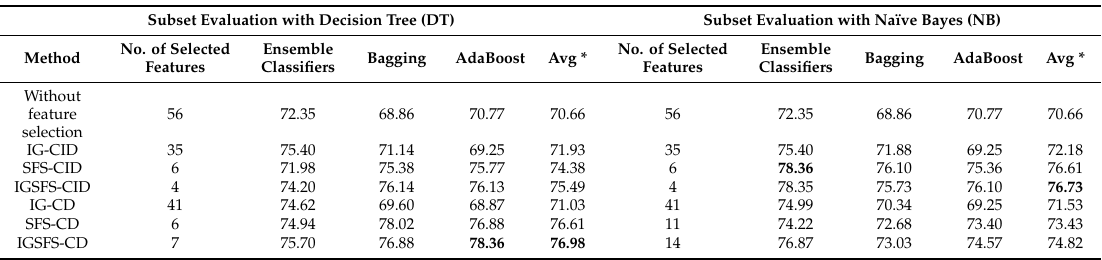
Table 4. Comparison of classification accuracy (%) using ensemble learning methods with LC_dataset-1.